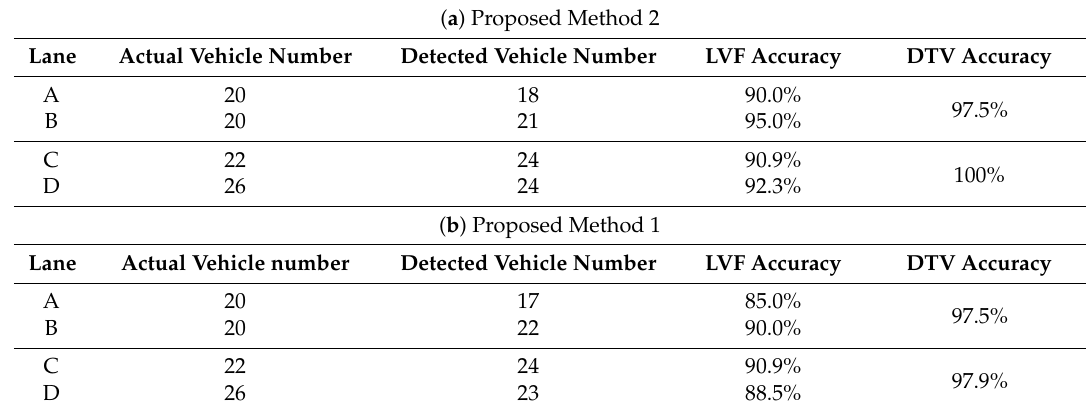
Table 3. Results of LVF and DTV detection during 1:10–1:20 AM (light traffic) using ( a ) proposed method 2 and ( b ) proposed method